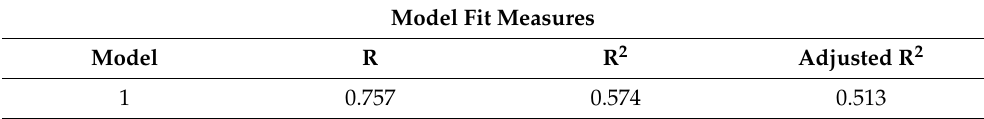
Table 4. R and R-squared of the model.